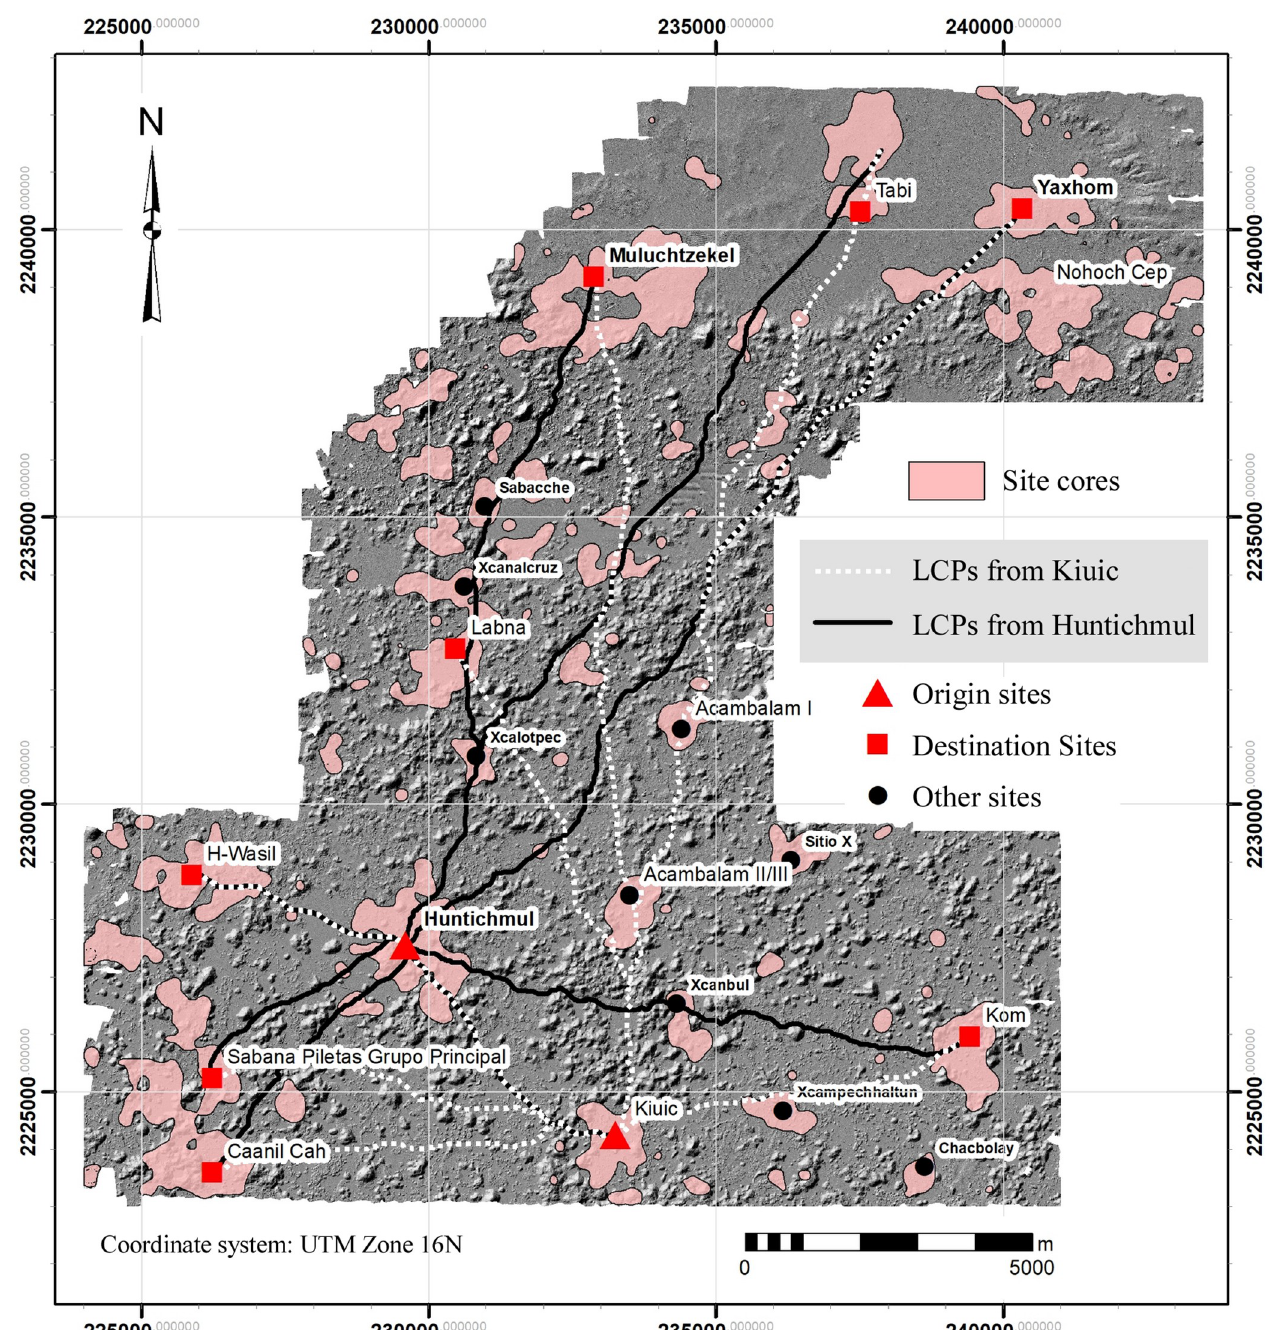
Fig 24. Least Cost Paths (LCPs) emanating from Kiuic and Huntichmul to eight other major destinations in the survey sample.